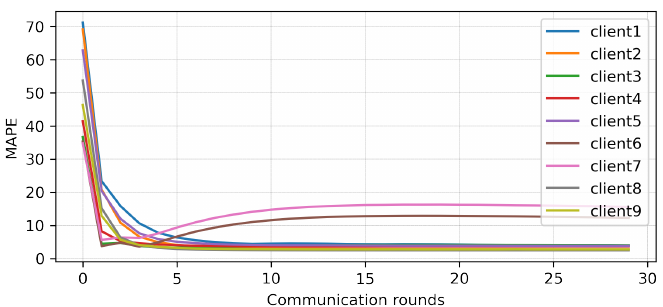
Figure 4. FL results with one global model after 30 communication rounds.